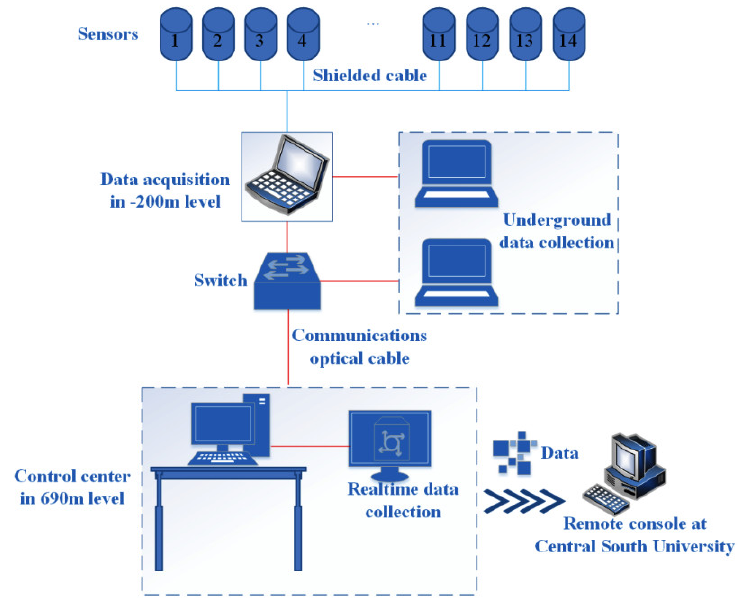
Figure 15. Schematic diagram of the real-time microseismic monitoring system in the Gaofeng mine. In total, 16 microseismic sensors were installed at the − 200 m and − 175 m levels, including 12 uniaxial geophone sensors and four triaxial geophone sensors. The data acquisition instruments were arranged in a special chamber at the − 200 m level. An optical cable was used for data transfer, and real-time data viewing was realized in the control center at the 690 m level. The microseismic data was also sent to the remote console at Central South University via wireless communication technology. If the fiber optic system was out of order, the technician still collected data at the − 200 m level. A real-time microseismic monitoring system is expected to help in disaster early